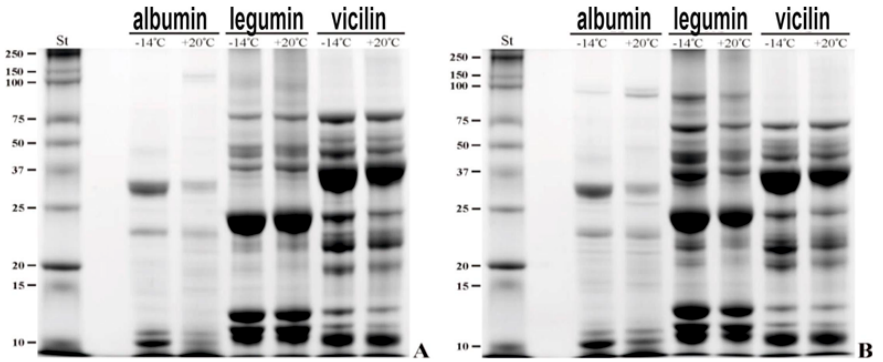
Figure 4. SDS-PAGE separations of albumin, vicilin, and legumin protein fractions from field bean ( Vicia faba var. minor ) cultivars Nadwi´sla´nski ( A ) and Dino ( B ) seeds stored at − 14 ◦ C and + 20 ◦ C